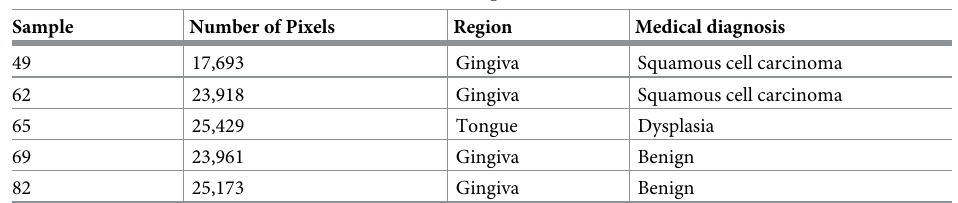
Table 3. Detailed information of the oral tissue lesion samples.